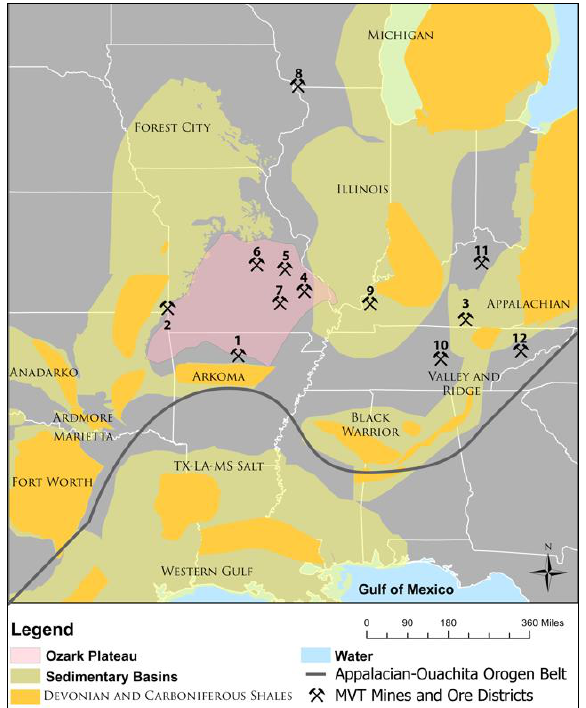
Figure 1. Map of the United States midcontinent region showing the location of sedimentary basins, shale plays, and major MVT mining districts and deposits (1 through 12): (1) Northern Arkansas, (2) Tri-State, (3) Burkesville deposit, (4) Old Lead Belt, (5) Southeast Missouri Barite, (6) Central Missouri Barite, (7) Viburnum Trend, (8) Upper Mississippi Valley, (9) Illinois–Kentucky Fluorspar, (10) Central Tennessee, (11) Central Kentucky, and (12) Eastern Tennessee. Modified from [4,9]. For drawing this basemap: https://www.eia.gov/maps/maps.htm (accessed on 29 December